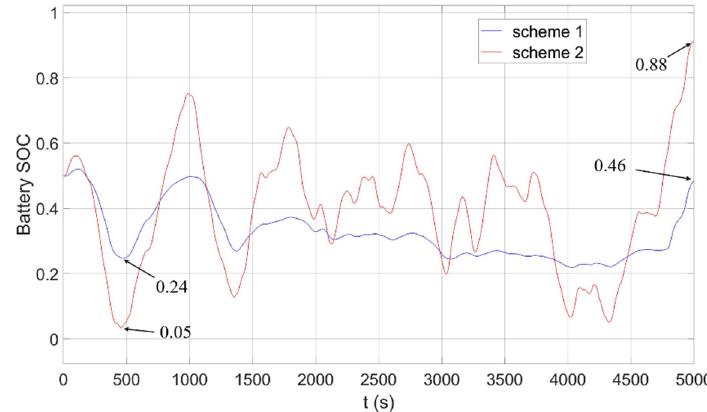
Figure 15. LiBs SOC comparison.